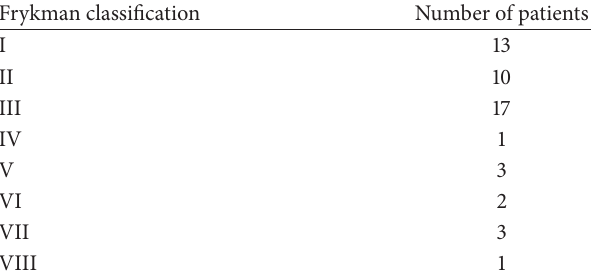
Table 2: Fracture pattern on initial postinjury